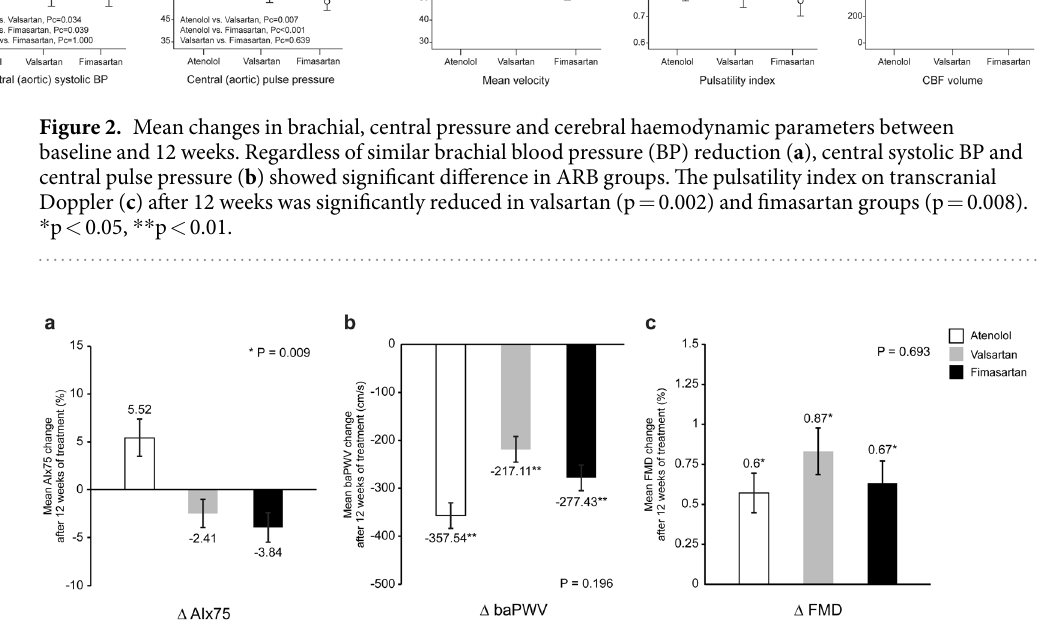
Figure 3. Mean changes in augmentation index ( a , b ) and other systemic parameters ( c , d ) from baseline. Augmentation index showed reduction only in the ARB groups. However, there were no differences in changes of baPWV and FMD among the three groups. * p < 0.05, ** p < 0.01 vs. baseline.